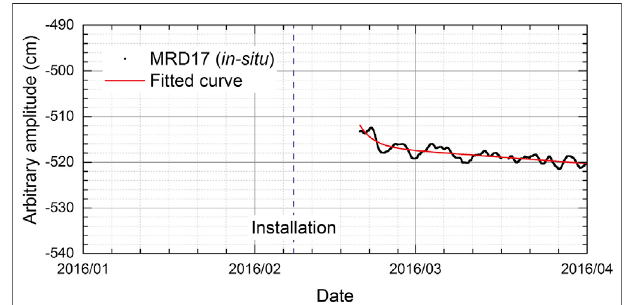
FIGURE 11 | In-situ measurement after tidal correction of MRD17. The fi tted curve derived from Eq. 1 is plotted as a red line. The installation date of the pressure sensor is indicated by the purple dashed line.